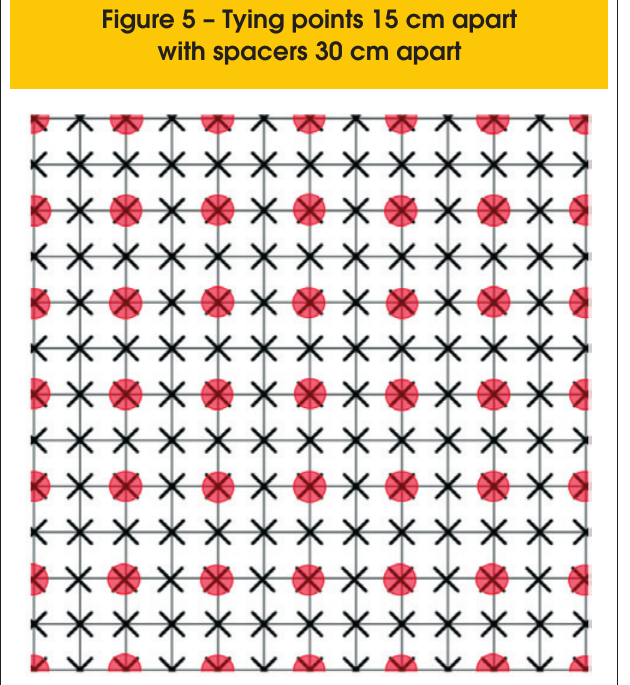
Figure 7 – Layout of spacers placed at